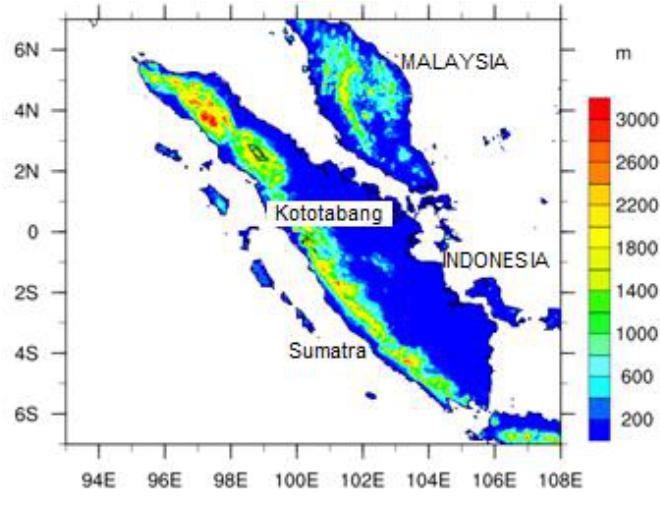
Figure 1. Location of study